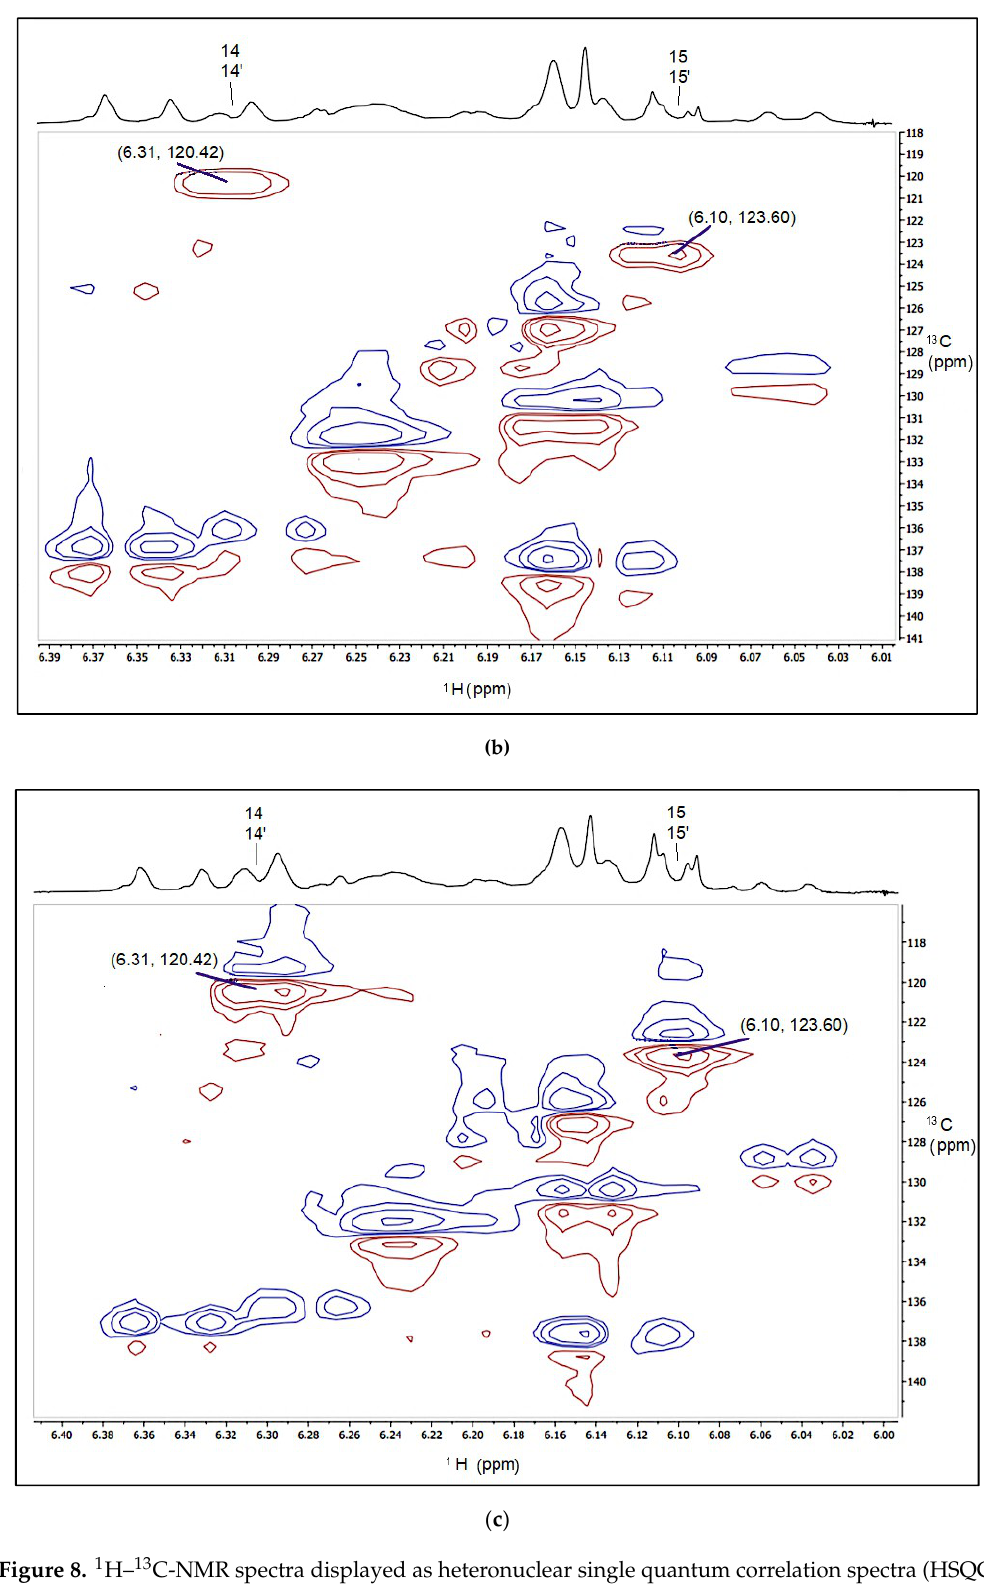
Figure 8. 1 H– 13 C-NMR spectra displayed as heteronuclear single quantum correlation spectra (HSQC) to show the chemical shifts values (ppm) for the carbon atoms C14, C15, C15′ and C14′ of phytoene extracted from ( a ) tomato, ( b ) chlorpropham and ( c ) norflurazon treated D. salina extracts. Numbers above the 1 H-NMR spectra indicate the carbon number of phytoene associated with the